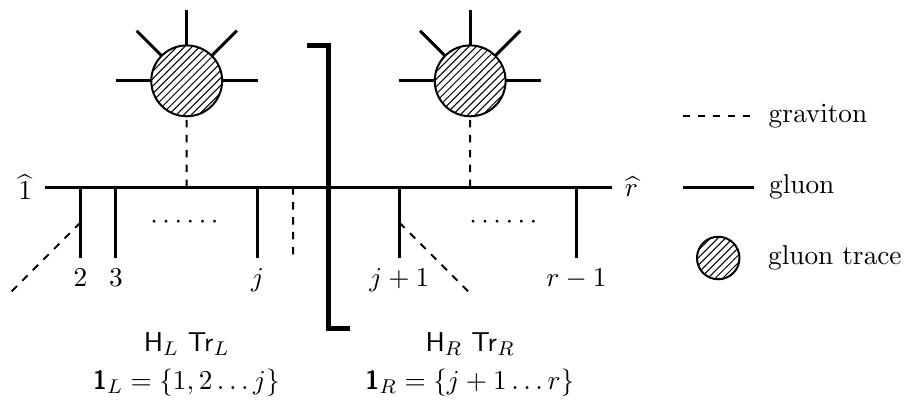
Figure 1 . A typical BCFW factorization channel of A (1 ; 2 : : : r j 222 j : : : j mmm k H